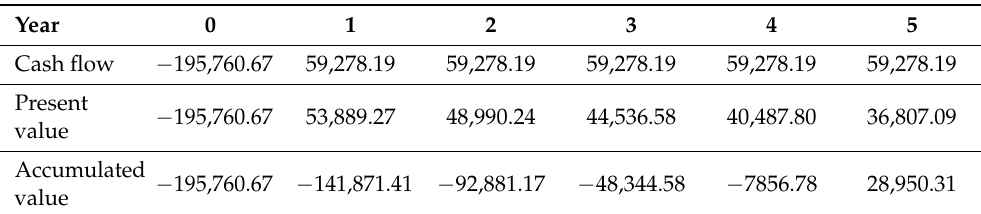
Table 12. Annual cash flow for palm oil neutralization sludge ( Elaeis guineensis , Jacq) and discounted payback analysis, profitability index analysis, internal rate of return (IRR) and net present value (NPV)